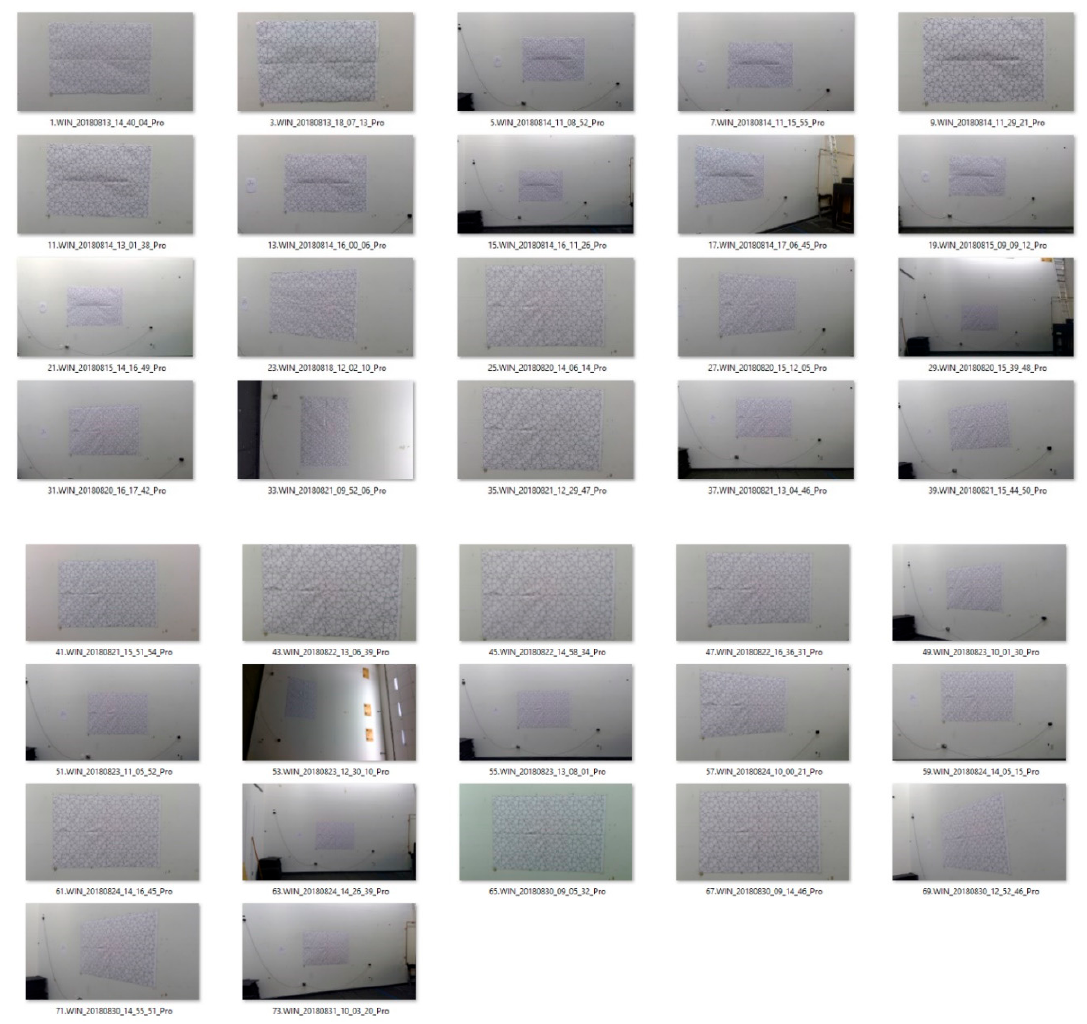
Figure 20. The first sample group of pictures. Figure A2. The first sample group of